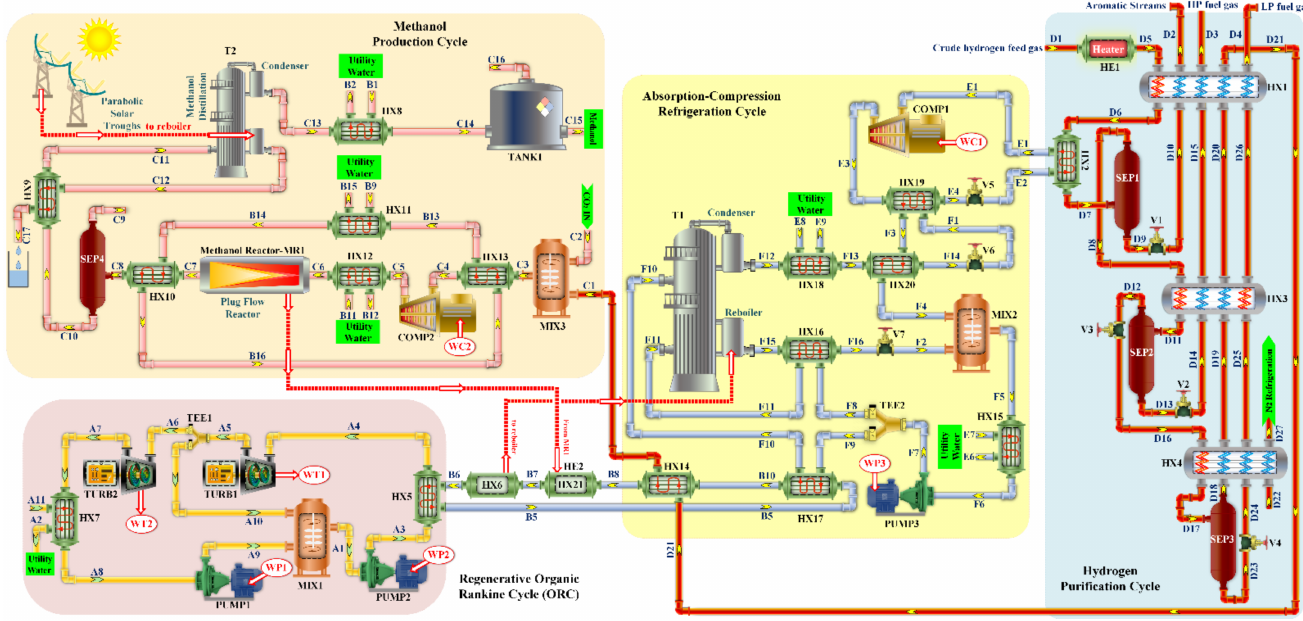
Figure 2. The process flow diagram (PFD) of the integrated structure.